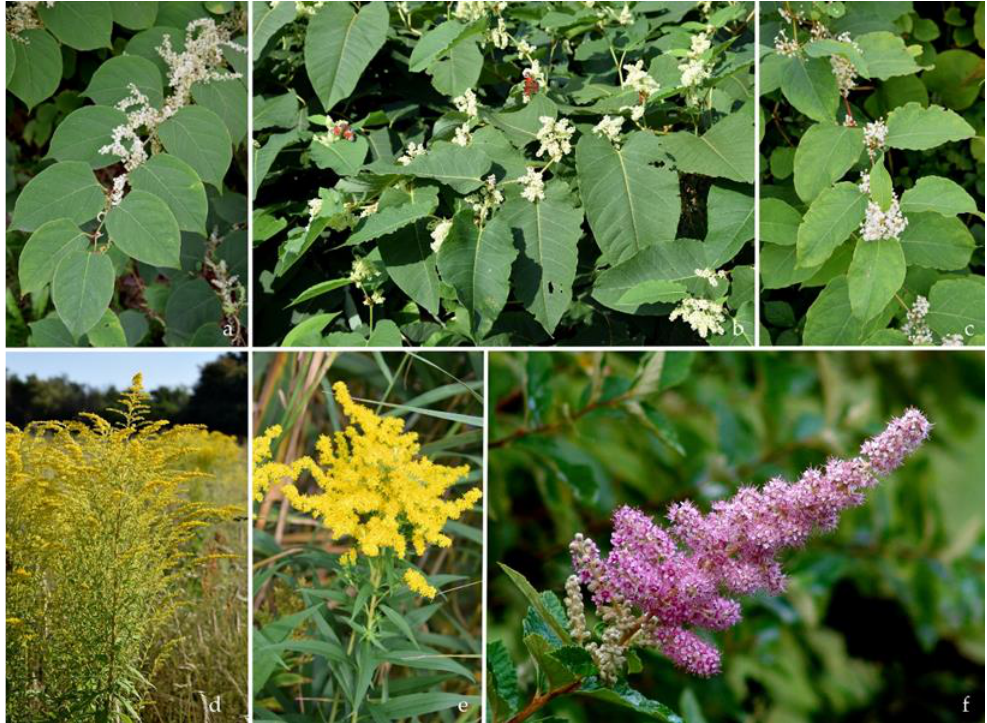
Figure 2. ( a – f ) Invasive plant species studied for energy purposes: Reynoutria japonica ( a ), R. sachalinensis ( b ), R. × bohemica ( c ), Solidago canadensis ( d ), S. gigantea ( e ), and Spiraea tomentosa ( f ) (photo: B. Wiatrowska).